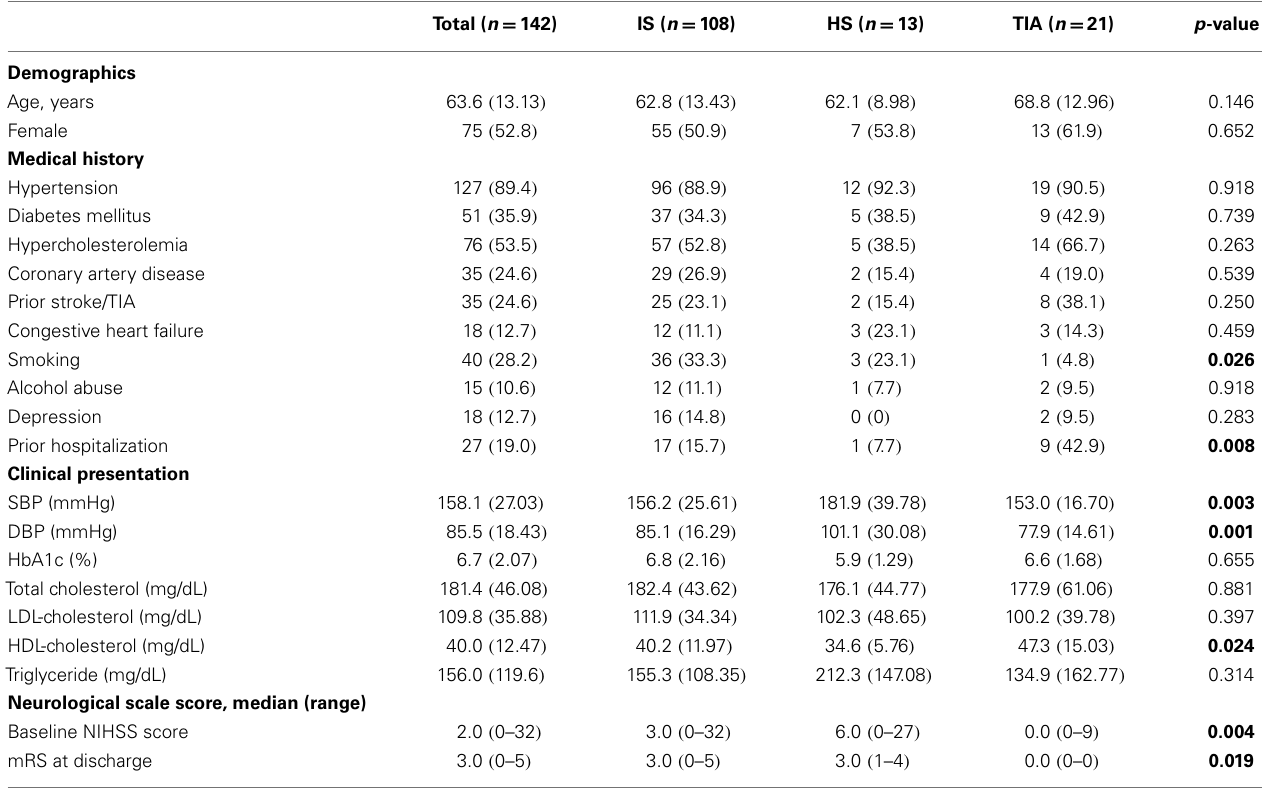
Table 1 | Baseline characteristics ofTRACS patients